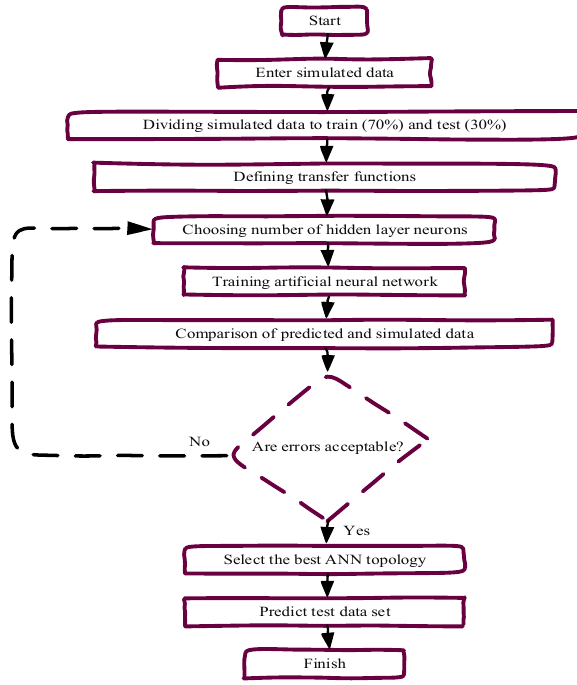
Figure 9. A flowchart for implementing the proposed model. The parameters and architecture of the obtained network for regime classification are indicated in Table 1 and Figure 10, respectively. Table 1. The parameters of the adopted neural network in the case of regime classification. Input